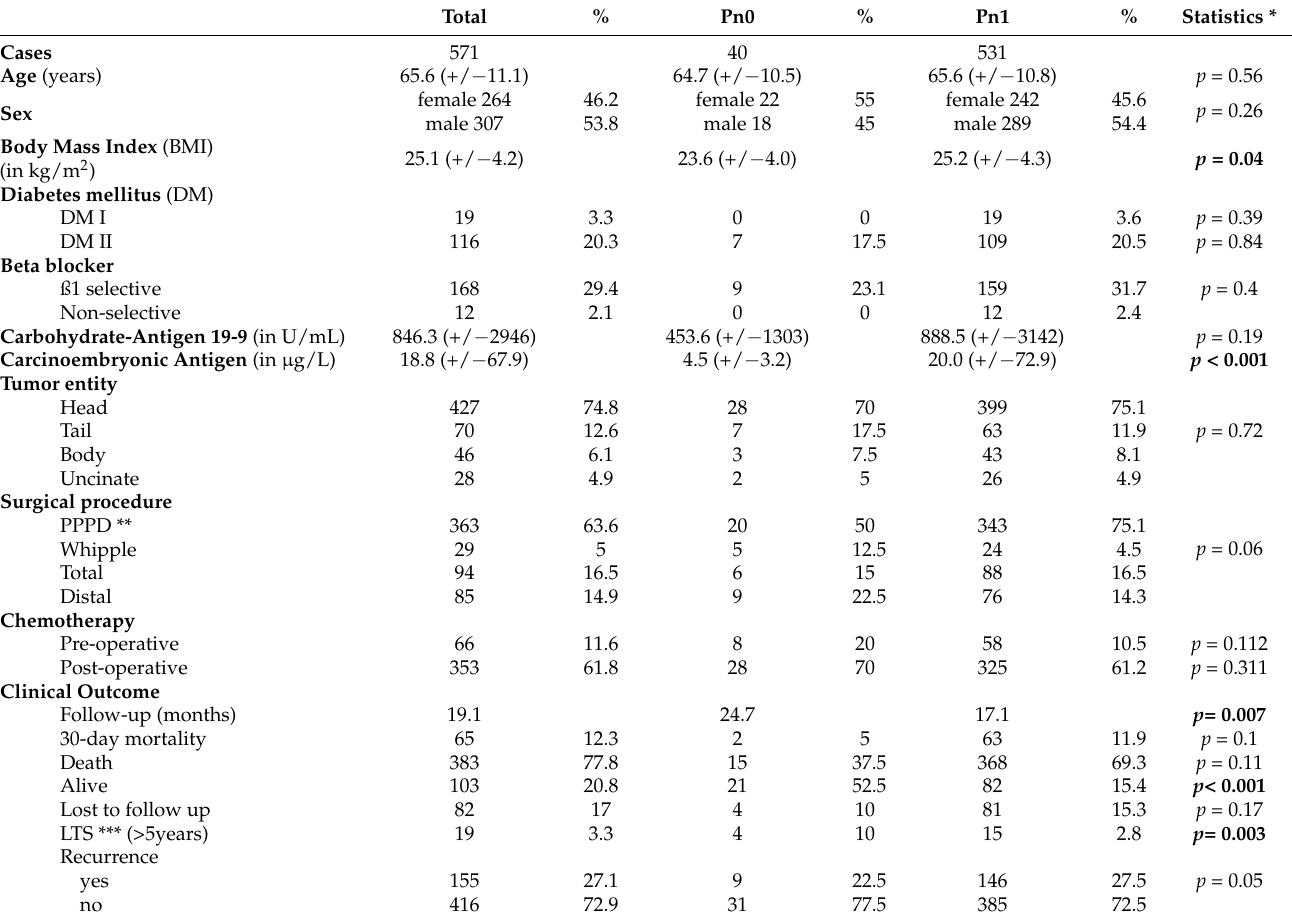
Table 1. Patient characteristics of entire study cohort, Pn0- and Pn1